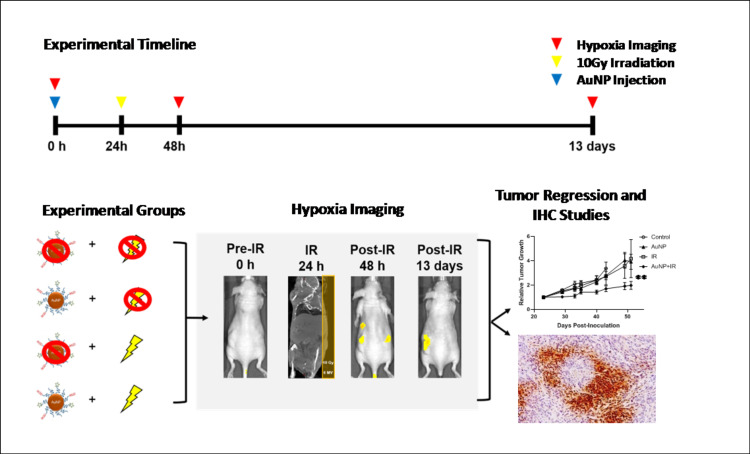
Experimental timeline and design.A schematic depiction of the experimental design to measure tumor hypoxia after radiation-induced tumor vascular damage is shown. In a human NSCLC xenograft model (A549) gold nanoparticles (AuNP, blue arrow) were i.v. administered to target tumor neovessels, and 10 Gy radiation was delivered (yellow arrow) 24 h post-AuNP injection. HypoxiSense680 fluorescence imaging (red arrow) was used to assess changes in tumor hypoxia pre (0 h) and post-treatment (48 h and 13 days) for all four groups (Control, AuNP, IR, and AuNP+IR). After imaging, mice were a) monitored for tumor progression or b) euthanized for immunohistochemistry studies to confirm tumor hypoxia.